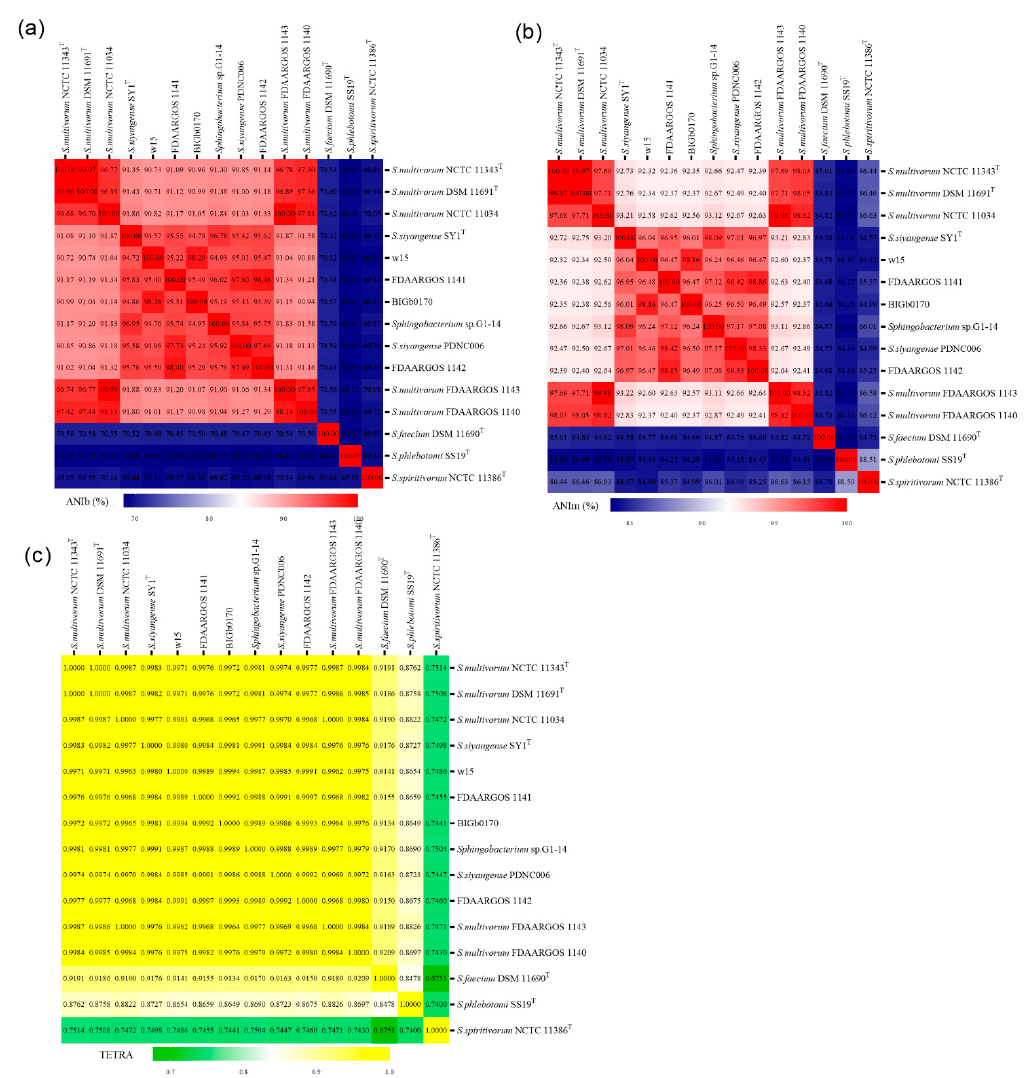
Figure 3. Heat maps of average nucleotide identities; ( a ) ANIb, ( b ) ANIm; and tetranucleotide frequencies ( c ) TETRA analyses of strains w15, BIGb0170, S. multivorum NCTC 11343 T , S. siyangense SY1 T and related species. Selected ANIb (> 95%) and TETRA (> 0.999) values were used as species